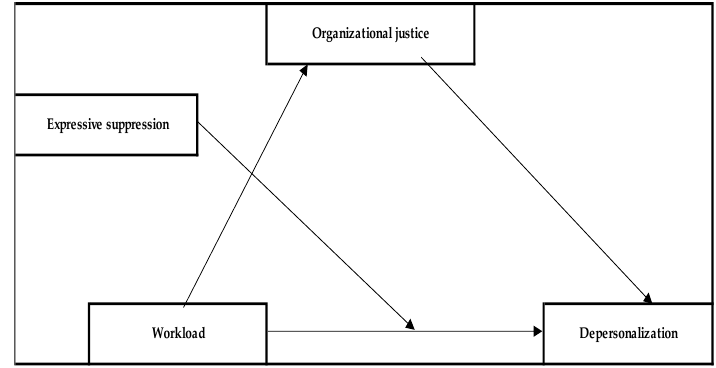
Figure 2. Model 2.